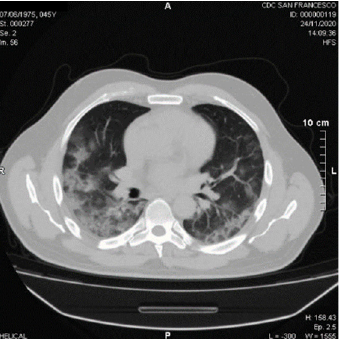
Figure 2. High resolution computed tomography (HRCT) chest, axial post-processed images, show- ing bilateral peripheral areas of ground-glass opacity (GGO). ing bilateral peripheral areas of ground-glass opacity